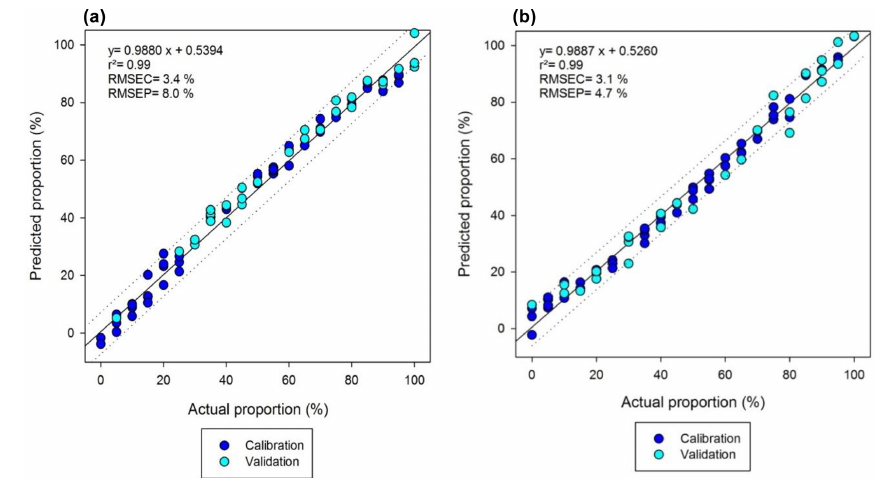
Figure 7. Building of FDVS-PLSR models for mining sources (a) and non-mining sources (b) .